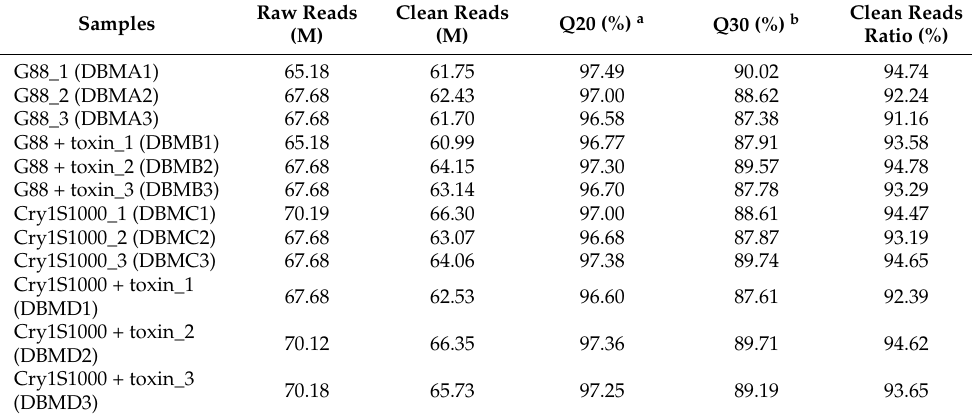
Table 1. Summary of the midgut transcriptome reads of P. xylostella. DBMA1, DBMA2, DBMA3: three sample replications from the susceptible strain (G88); DBMB1, DBMB2, DBMB3: three sample replications from the susceptible strain with toxin treatment (G88 + toxin); DBMC1, DBMC2, DBMC3: three sample replications from the resistant strain (Cry1S1000); DBMD1, DBMD2, DBMD3: three sample replications from the resistant strain with toxin treatment (Cry1S1000 + toxin).